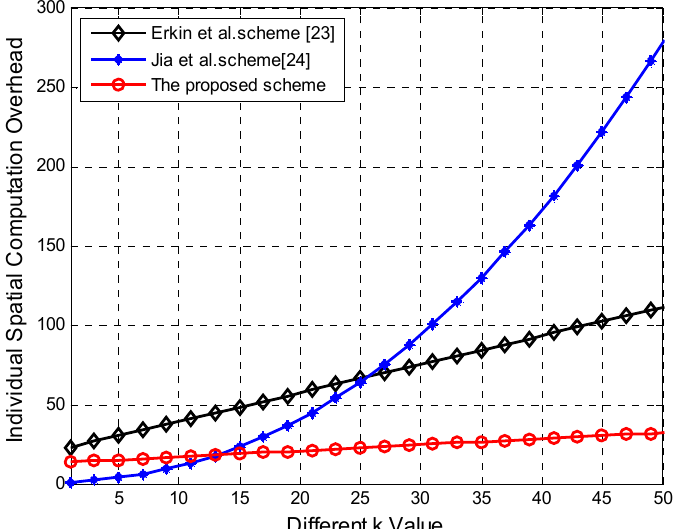
Figure 4. Variety of spatial computation overhead per node with the value k.